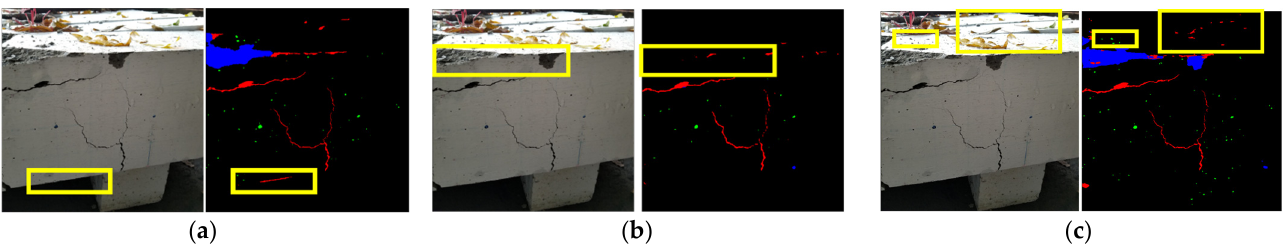
Figure 21. U-Net and DeepLabV3+ comparison on fine-grained object segmentation. Figure 21. Comparison on the use of different regularizations combination in U-Net and DeepLabV3+.